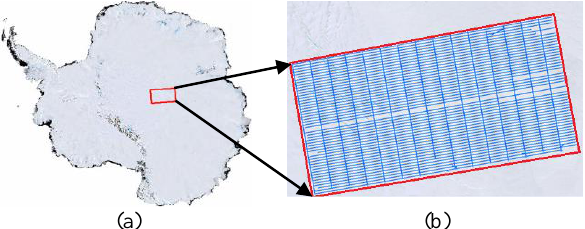
Figure 7 . Large-scale experimental region and flight lines. (a) AGAP region in Antarctica, (b) flight lines in AGAP region.